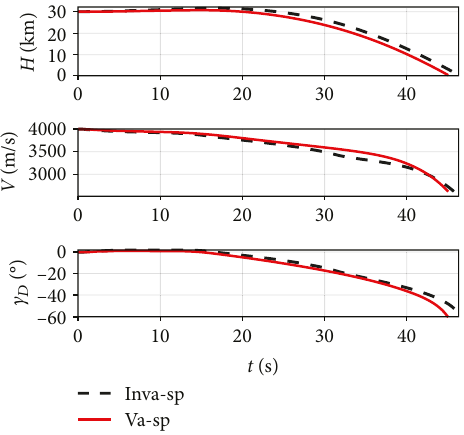
Figure 10: Curves representing the height, velocity, and terminal angle. Inva_sp: invariable span; Va-sp: variable span.